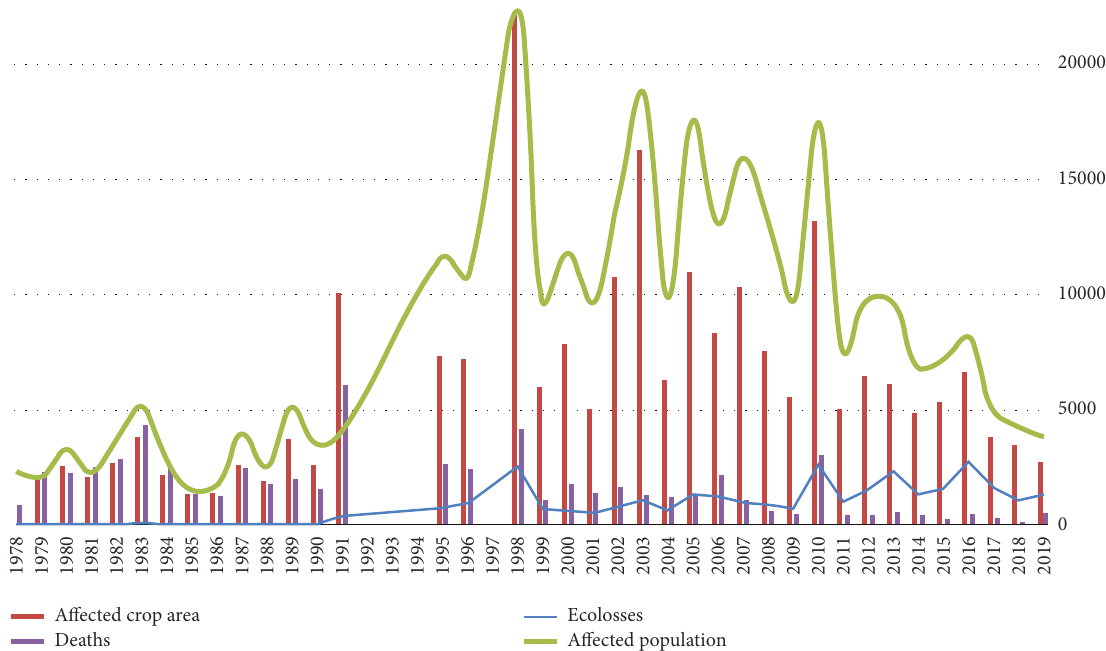
Figure 2: FD in the YRb from 1978 to 2019 (lack of data for 1992-1994, and 1997). Data source: Flood and Drought Disaster in the Yangtze River basin compiled by Yangtze Water Resources Commission of the Ministry of Water Resources; China Water Conservancy Yearbook; China Flood and Drought Disaster